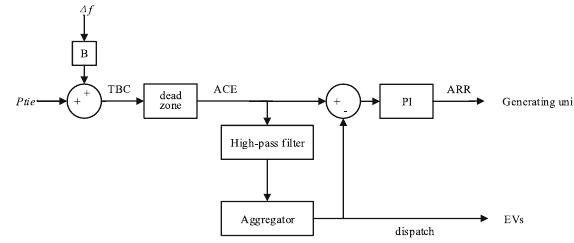
Fig. 4 The control loop with high-frequency components of ACE